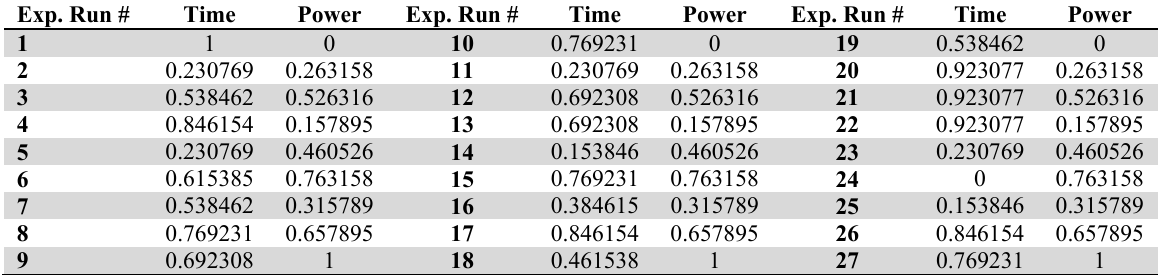
Summary of standardized decision matrix